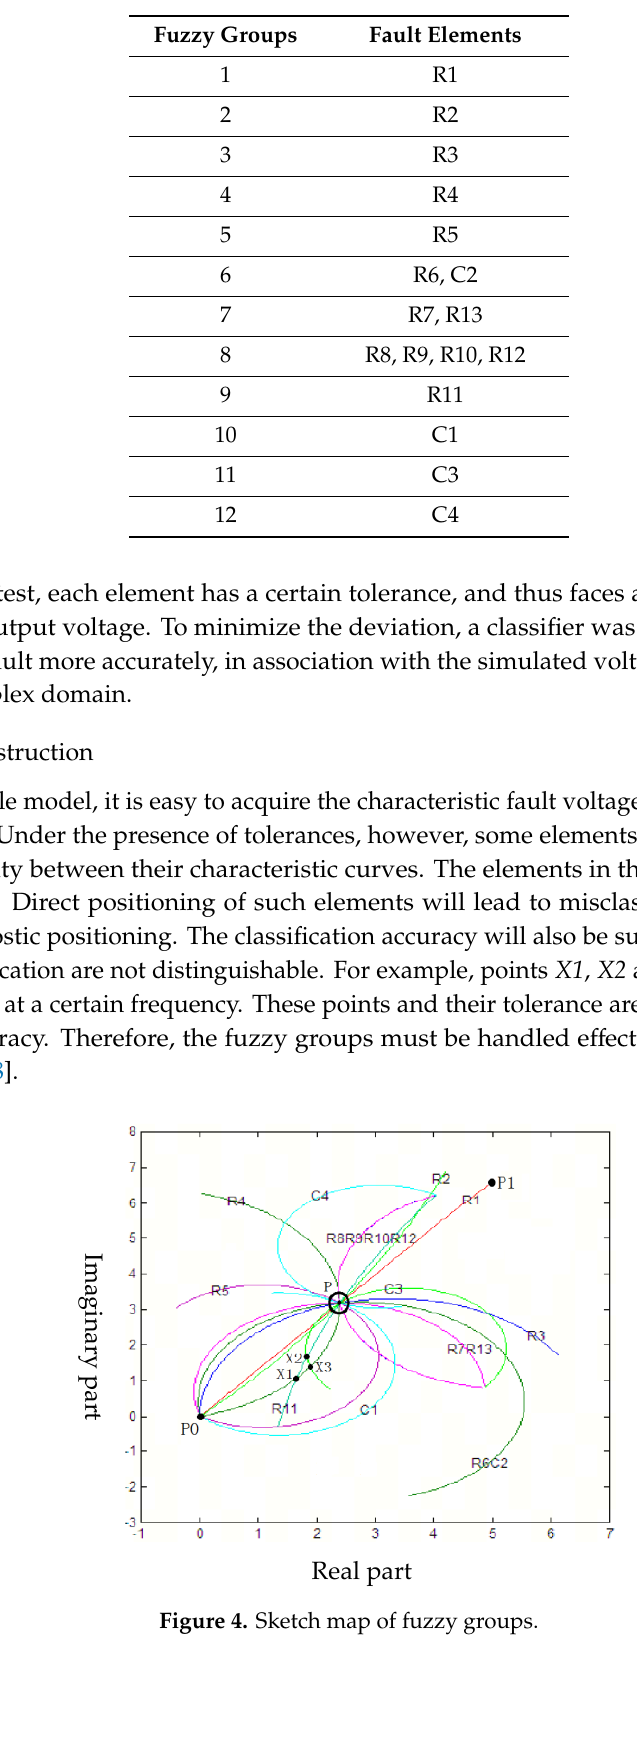
Table 2. Fuzzy groups of the Leapfrog circuit.